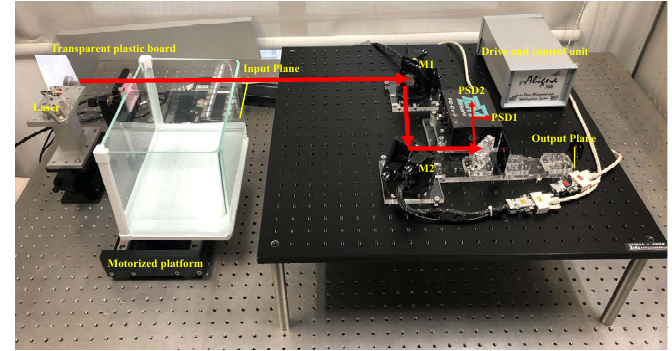
Figure 6. The photograph of the experimental